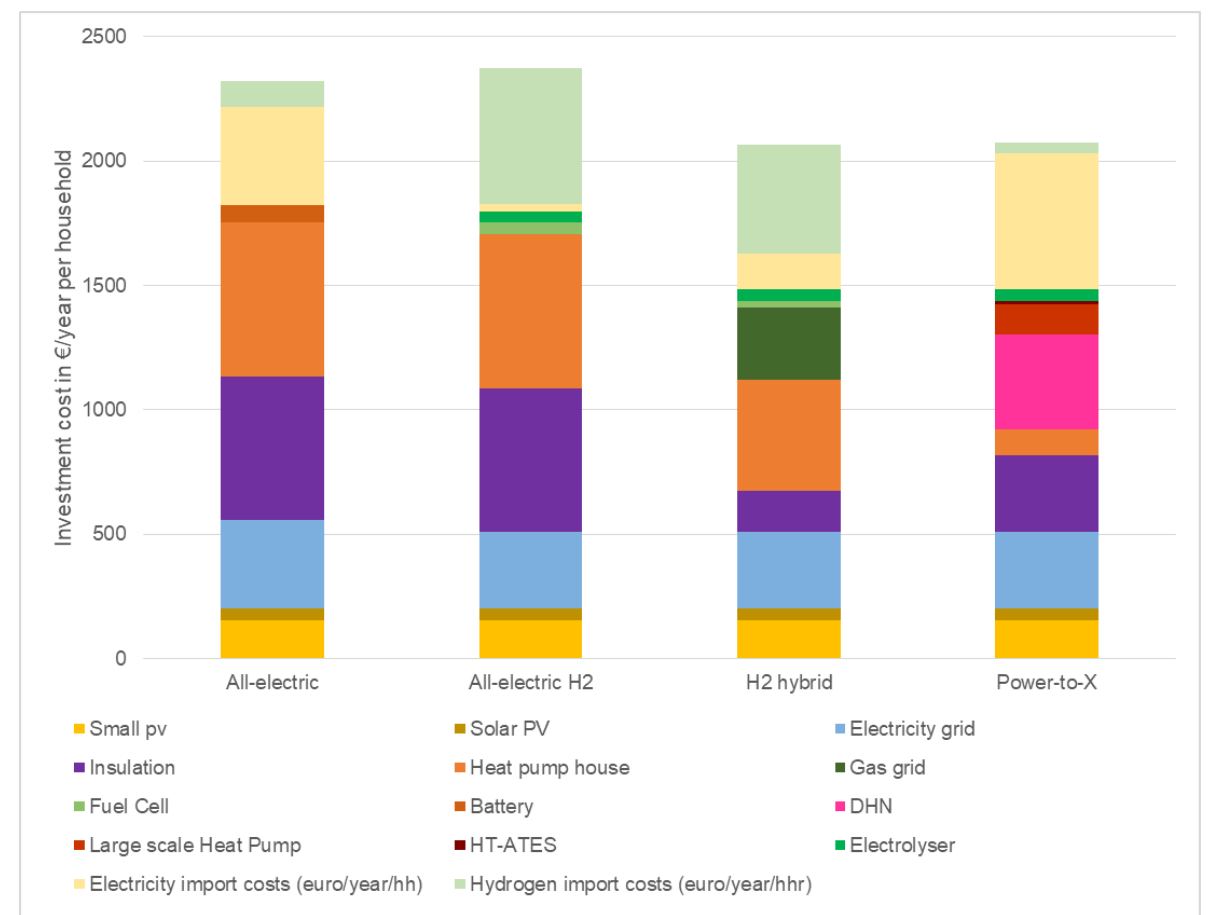
Figure 15. Yearly cost breakdown of the different components in the four scenarios. Costs include discounted CAPEX and OPEX (OM and electricity/hydrogen costs) and are divided over the 2000 households. The all-electric H 2 scenario has the highest costs (2370 €/household/year), mainly due to the high investment costs for insulation (retrofitting from label D to label A), the heat pump and the import costs for hydrogen. The insulation and heat pump costs are important cost factors because those are investments for each individual house. The scenarios with less retrofitting (H 2 hybrid and power-to-X) have more costs for conversion, storage and infrastructure (hydrogen and heat), but these costs are shared among all households, resulting in overall lower costs per household.